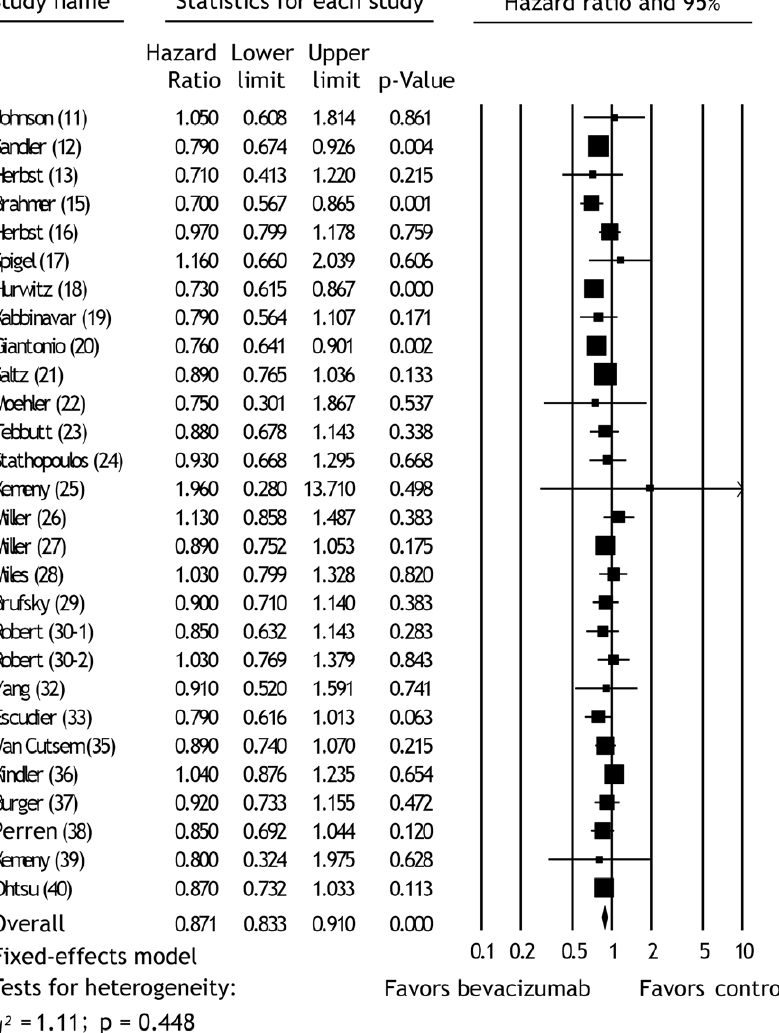
Figure 3. Meta-analysis of the hazard ratios of overall survival between bevacizumab and control therapy using random effect model. Bars, 95% confidence intervals (CI) of hazard ratio in patients receiving bevacizumab versus controls. The areas of the squares are proportional to the weights used for combining the data. The center of the lozenge gives the combined hazard ratio. The hazard ratio was considered statistically significant if the 95% CI for the overall hazard ratio did not overlap one.